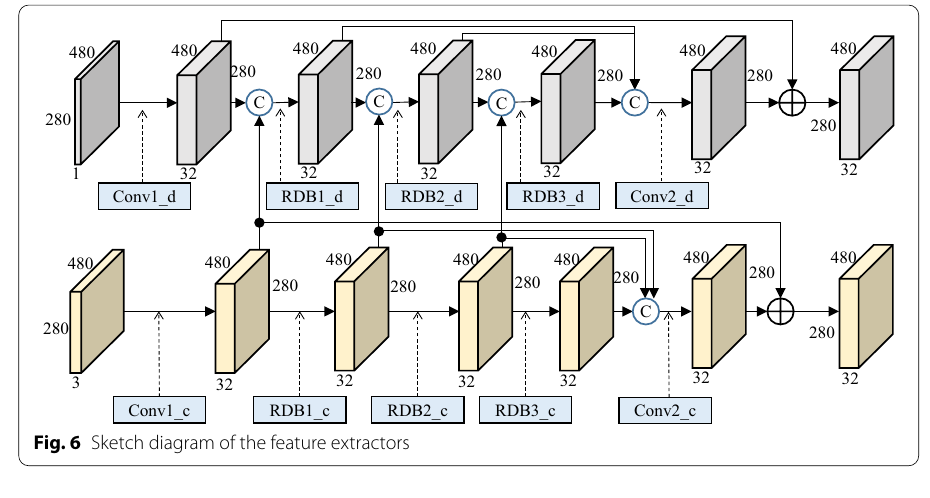
Fig. 6 Sketch diagram of the feature extractors